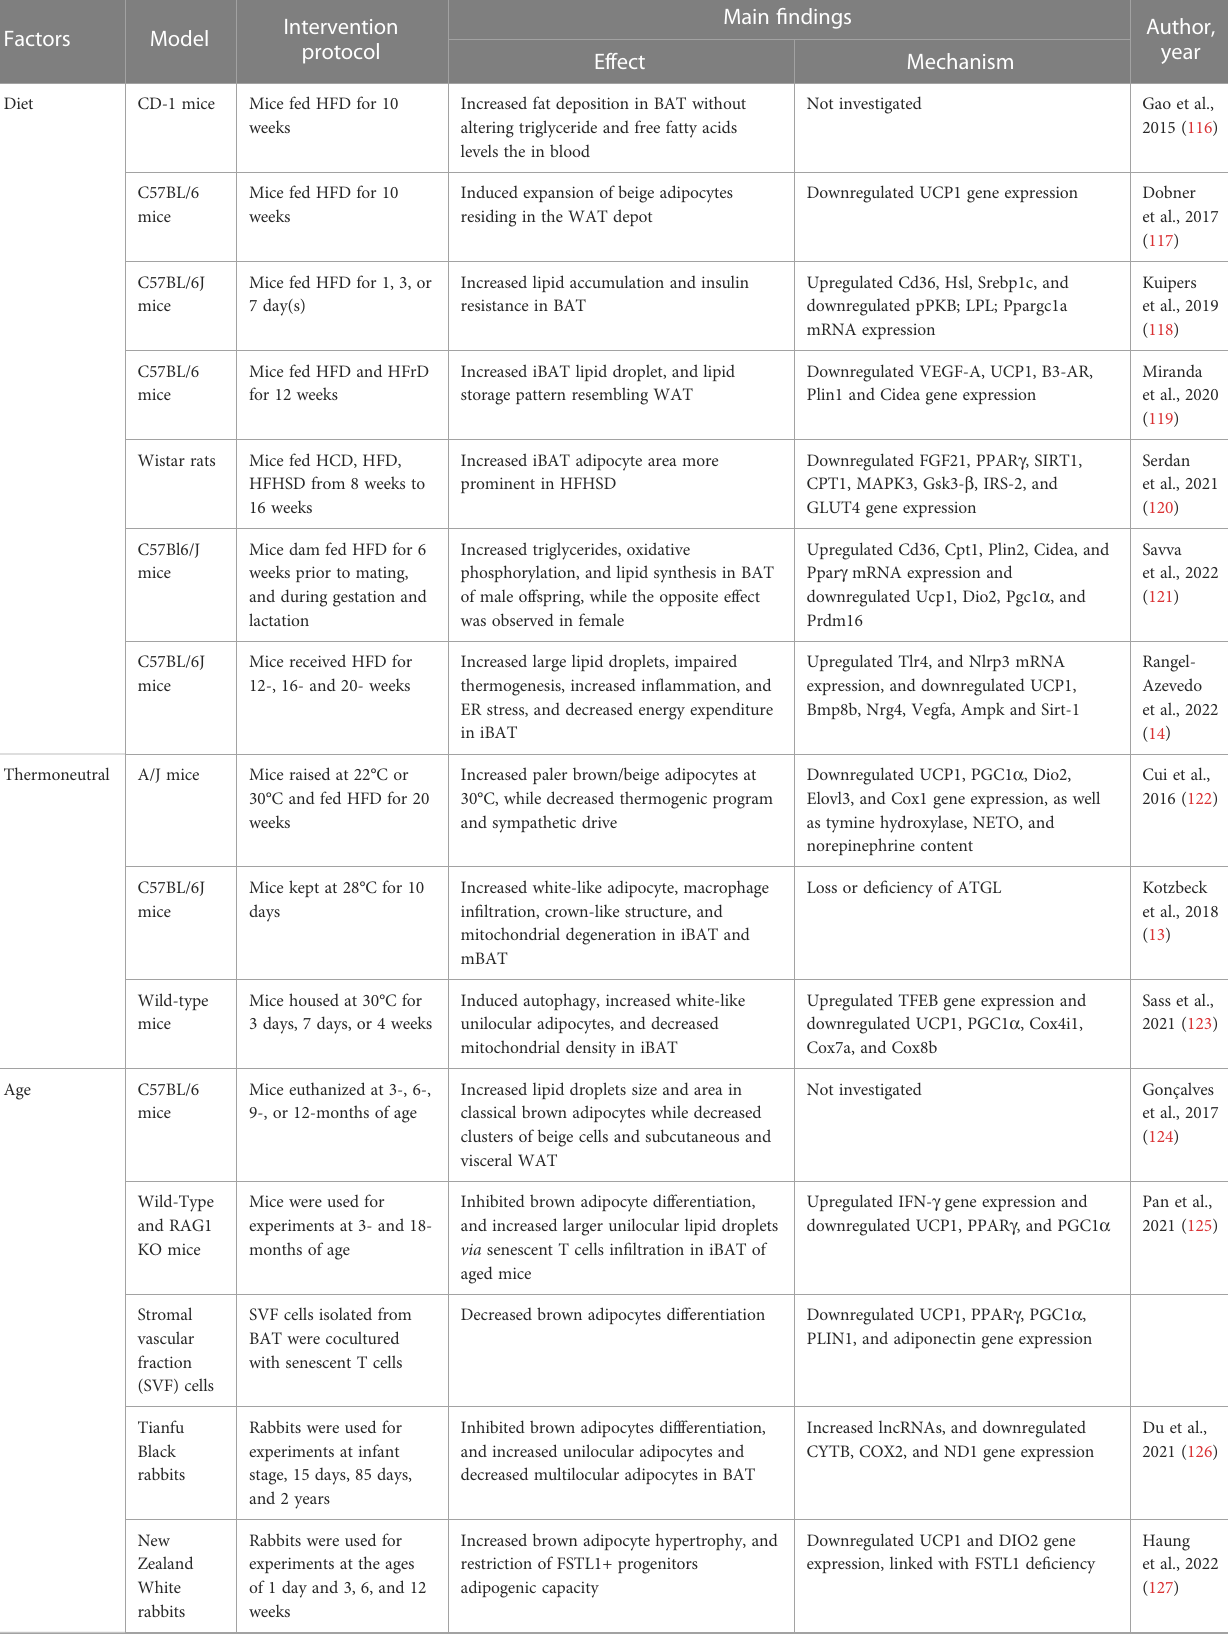
TABLE 1 Summary of evidence reporting on BAT/beige adipose tissue whitening-induced by diet, thermoneutrality, age, and